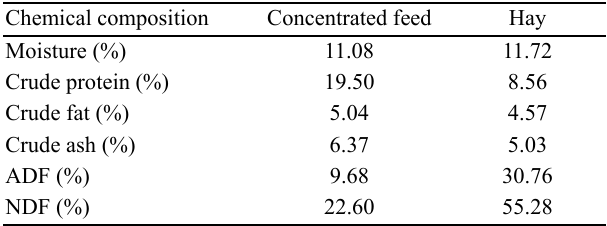
Table 1. Chemical composition of experimental diets Chemical